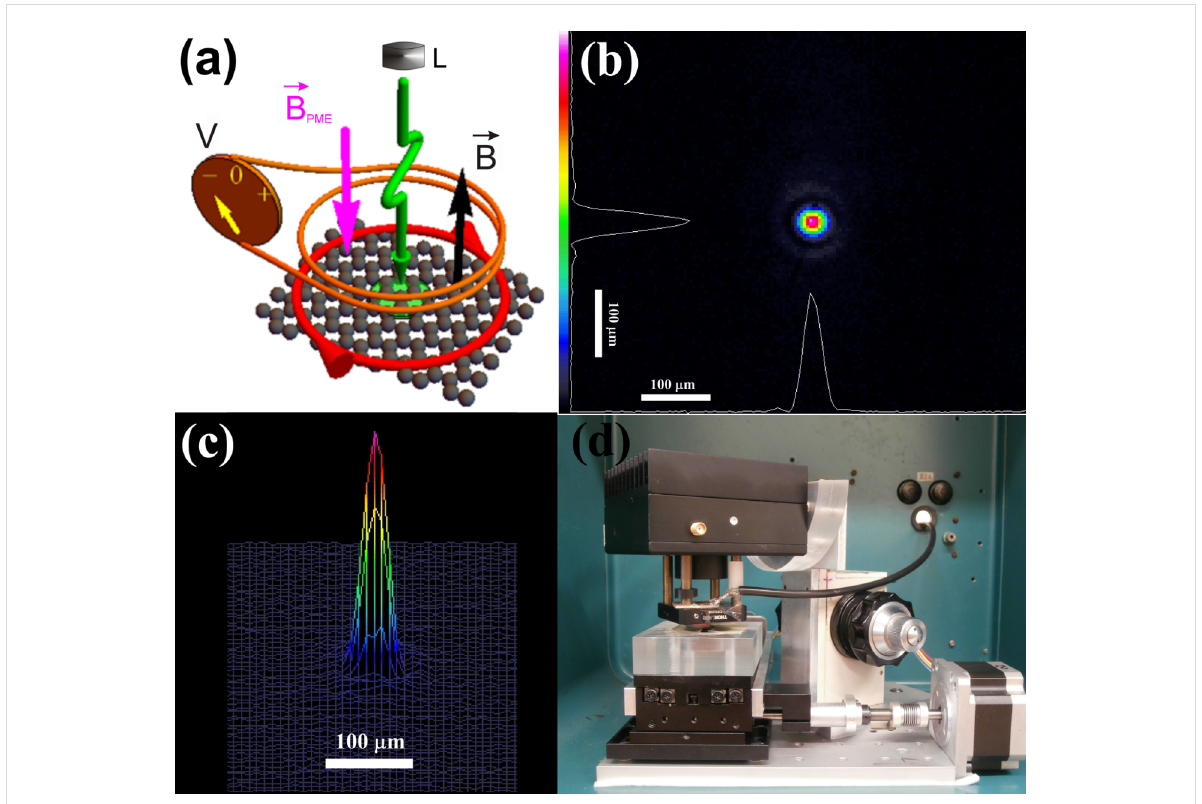
Figure 4: Schematic presentation (a) of the measuring set up used for the induction technique of PME investigations of a point-illuminated 2D semi- conductor in Corbino configuration (V – nanovoltmeter connected to a measuring coil; L – electronically chopped light source; the other symbols have the same meanings as in Figure 1); (b) 2D and (c) 3D mapping of the illumination intensity; and (d) a picture of the main part of the measurement set